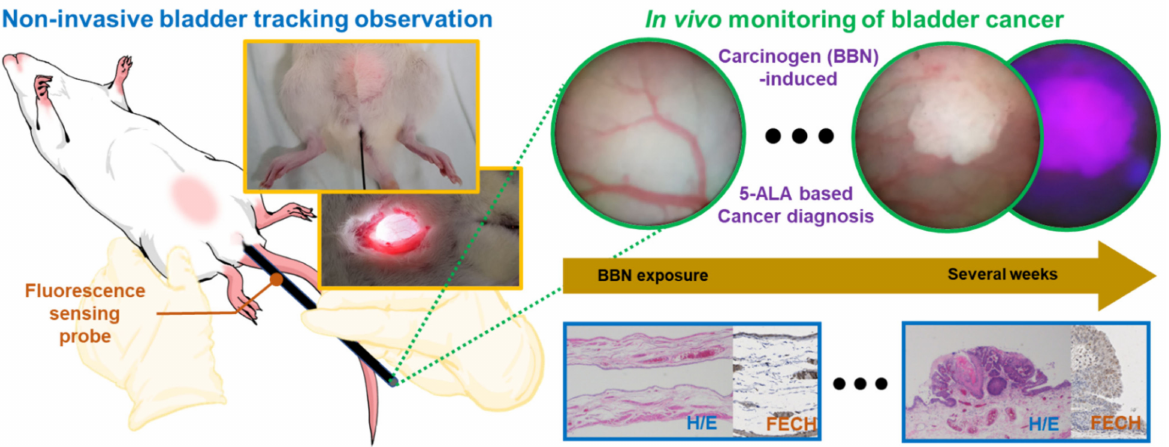
Figure 1. Schematic diagram and images of the experimental minimally invasive monitoring proce- dure and fluorescence imaging of BBN-induced bladder cancer using a flexible fluorescence imaging microprobe. 5-ALA, 5-aminolevulinic acid; BBN, N-butyl-N-(4-hydroxybutyl)nitrosamine; H/E, hematoxylin/eosin staining; FECH, ferrochelatase